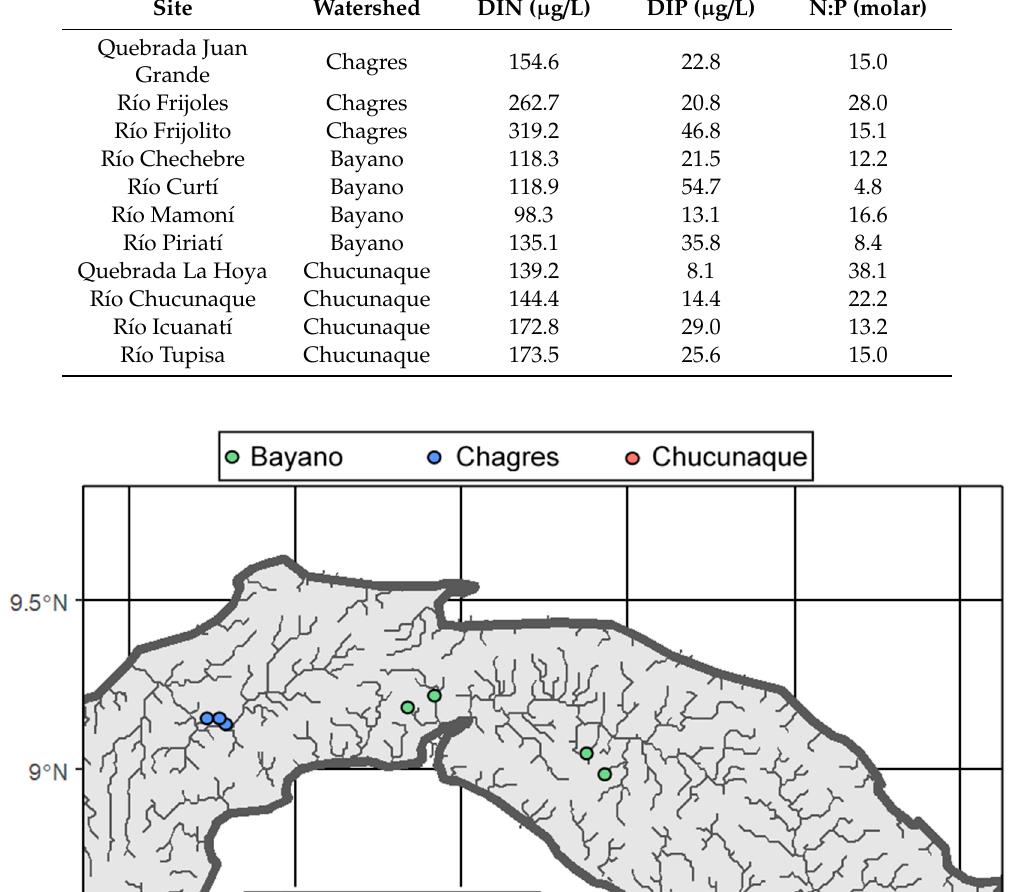
Table 1. Dissolved inorganic nitrogen (DIN) and dissolved inorganic phosphate (DIP) concentrations of the sample locations across eastern Panama. Samples were collected during the dry seasons (February–April) of 2013 and 2014.